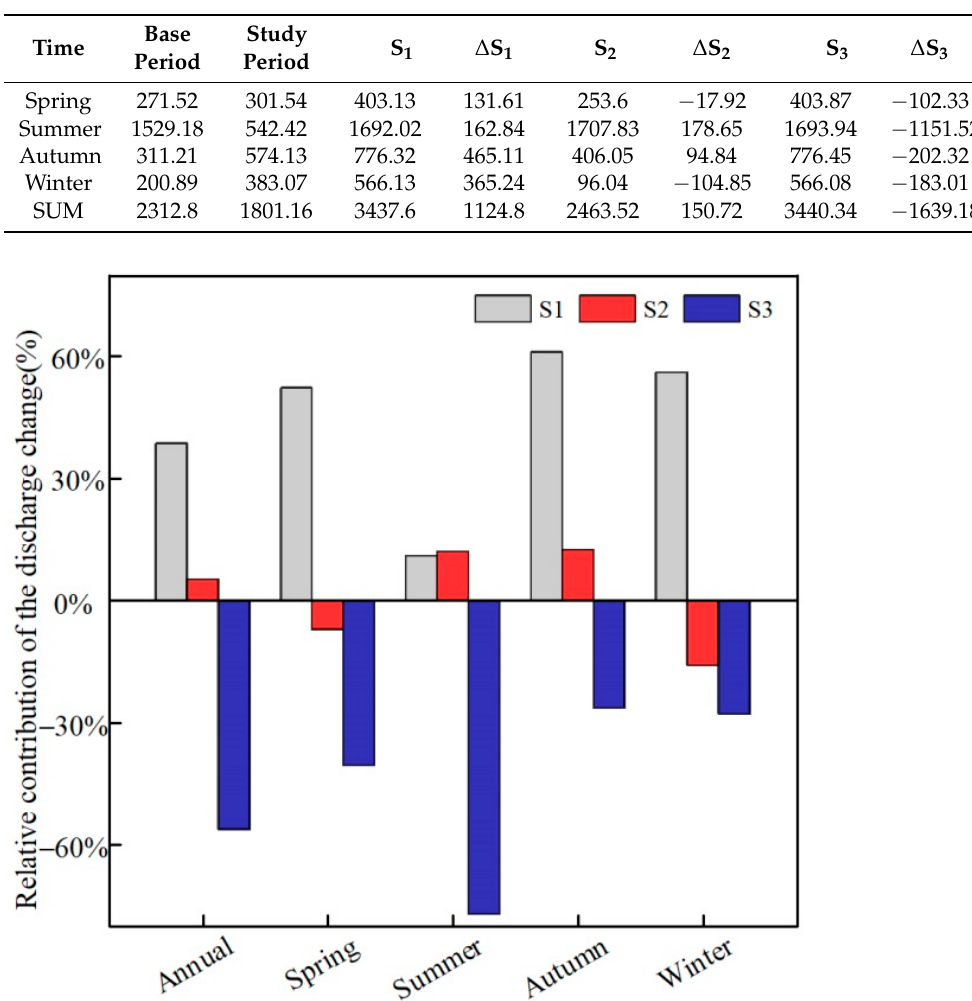
Table 2. Runoff in different scenarios (10 4 m 3 ).